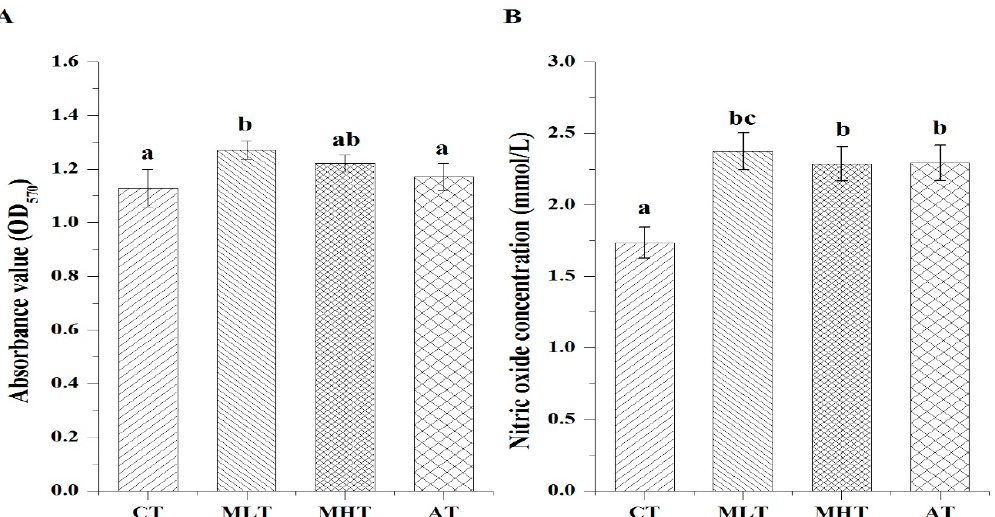
Figure 1. E ff ects of MLPs on the proliferation ( A ) and NO production ( B ) of lymphocytes from weanling pigs. Vertical bars represent standard errors ( N = 5, samples were from one pen of each treatment). Values are expressed in means. Mean values with di ff erent letters ( a, b, c ) are significantly di ff erent within a cluster of bars, not across clusters of bars ( P <